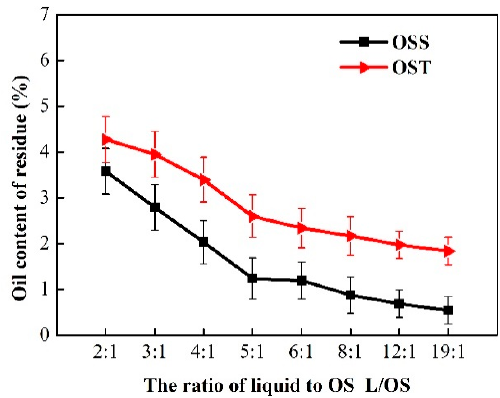
Figure 6. Influence of the ratio of liquid to OS on the oil content of residue. Flotation conditions: C c = 400 mg/L, T t = 25 min, T p = 33 °C, R s = 1340 r/min. C c = 400 mg/L, T t = 25 min, T p = 33